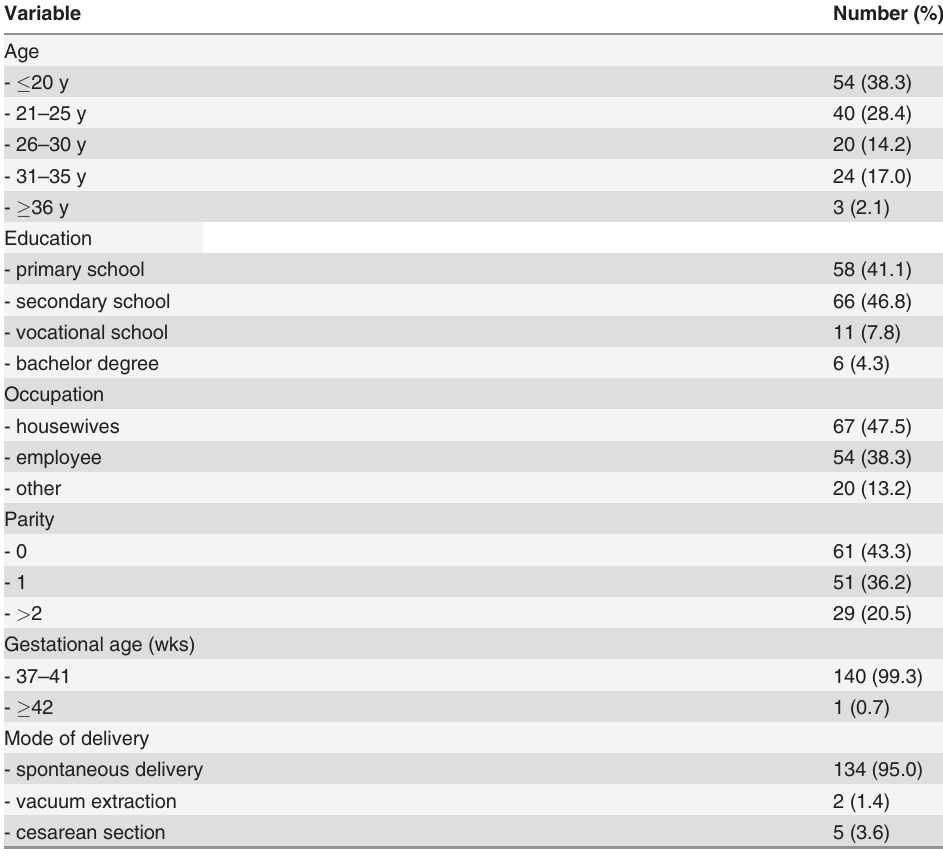
Table 1. Demographic characteristics of 141 pregnant